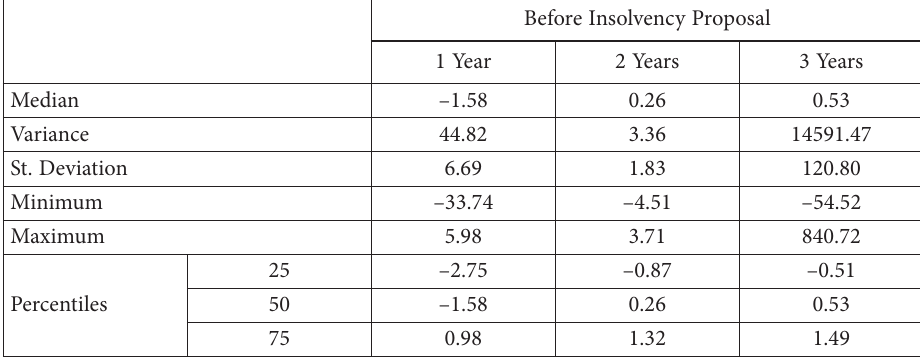
Table 10. Descriptive statistics of Altman Z-Score (source: author based on Bisnode MagnusWeb)